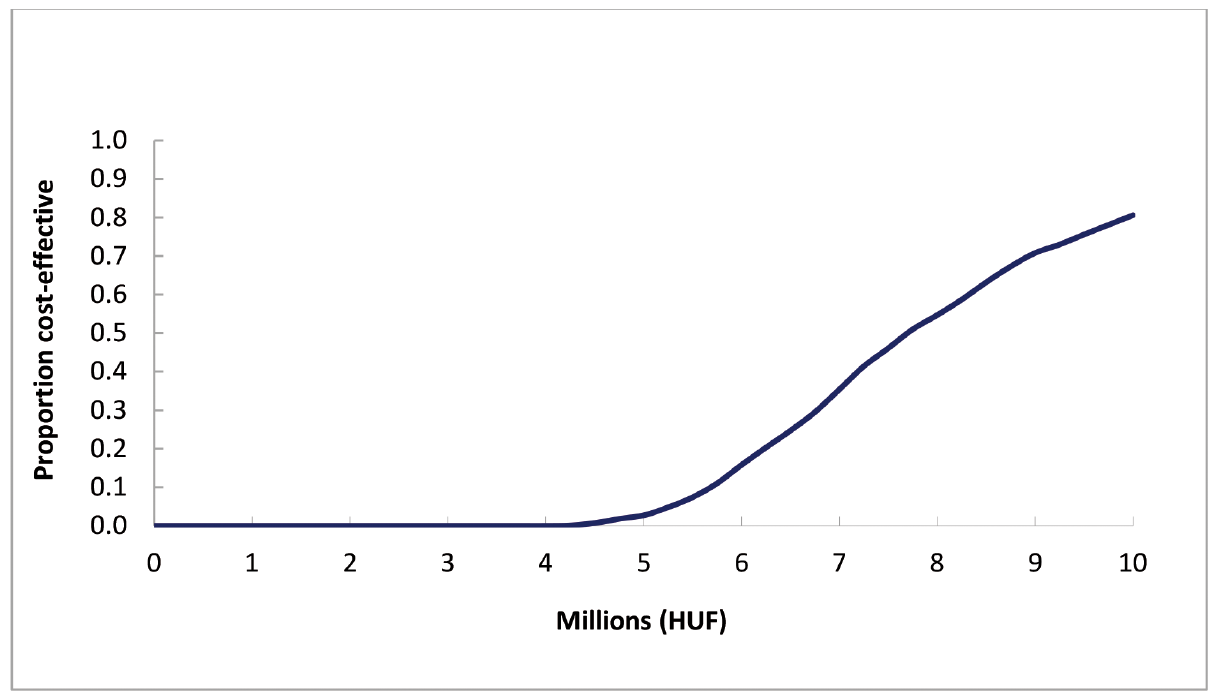
Figure 6. Cost-effectiveness Acceptability Curve in Treatment-naive Patients